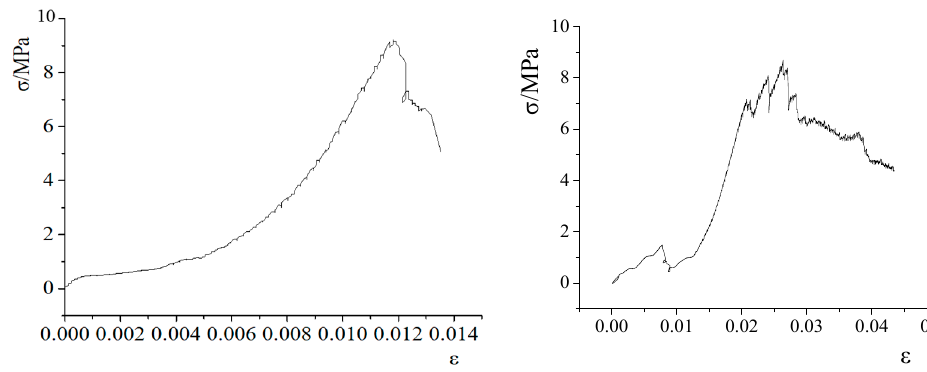
Figure 4. Stress–strain curve of mudstone under uniaxial compression.